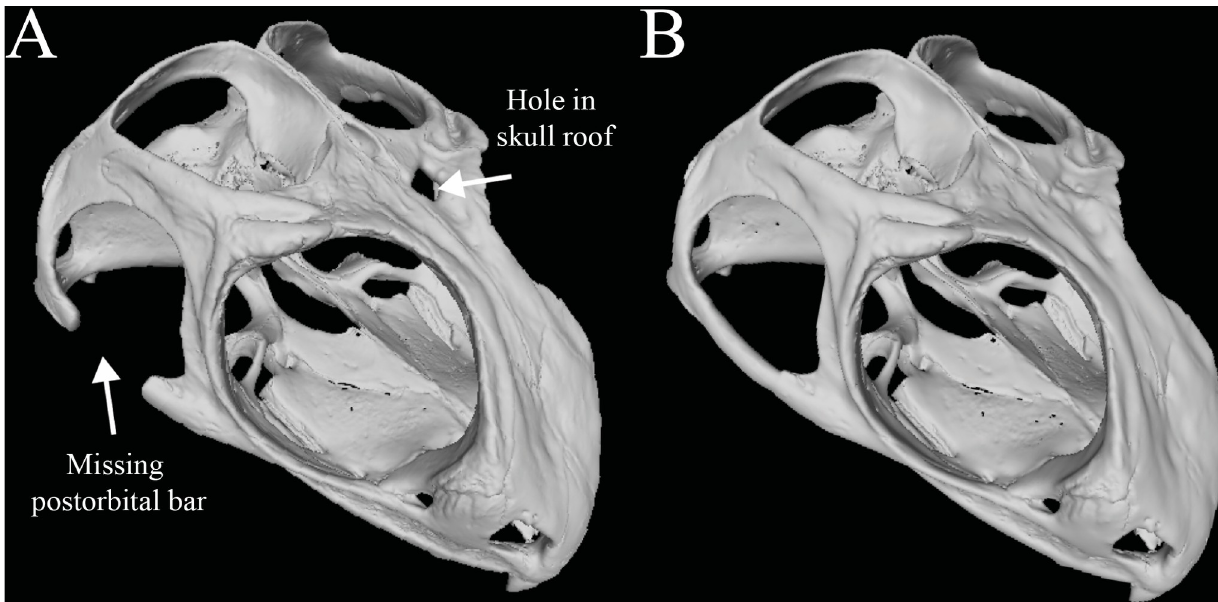
Fig 3. 3D reconstruction of Sphenodon punctatus (UF 11978, Florida Museum of Natural History) before (A) and after (B) post-processing. 3D mesh was downloaded directly from Morphosource.org. (A) Mesh was artificially damaged to create a hole in the roof of the skull and a missing lower temporal bar. B. 3D mesh file post-processed in Autodesk Maya and Autodesk Fusion 360 with patched hole and reconstructed temporal bar. Images generated using Meshlab.